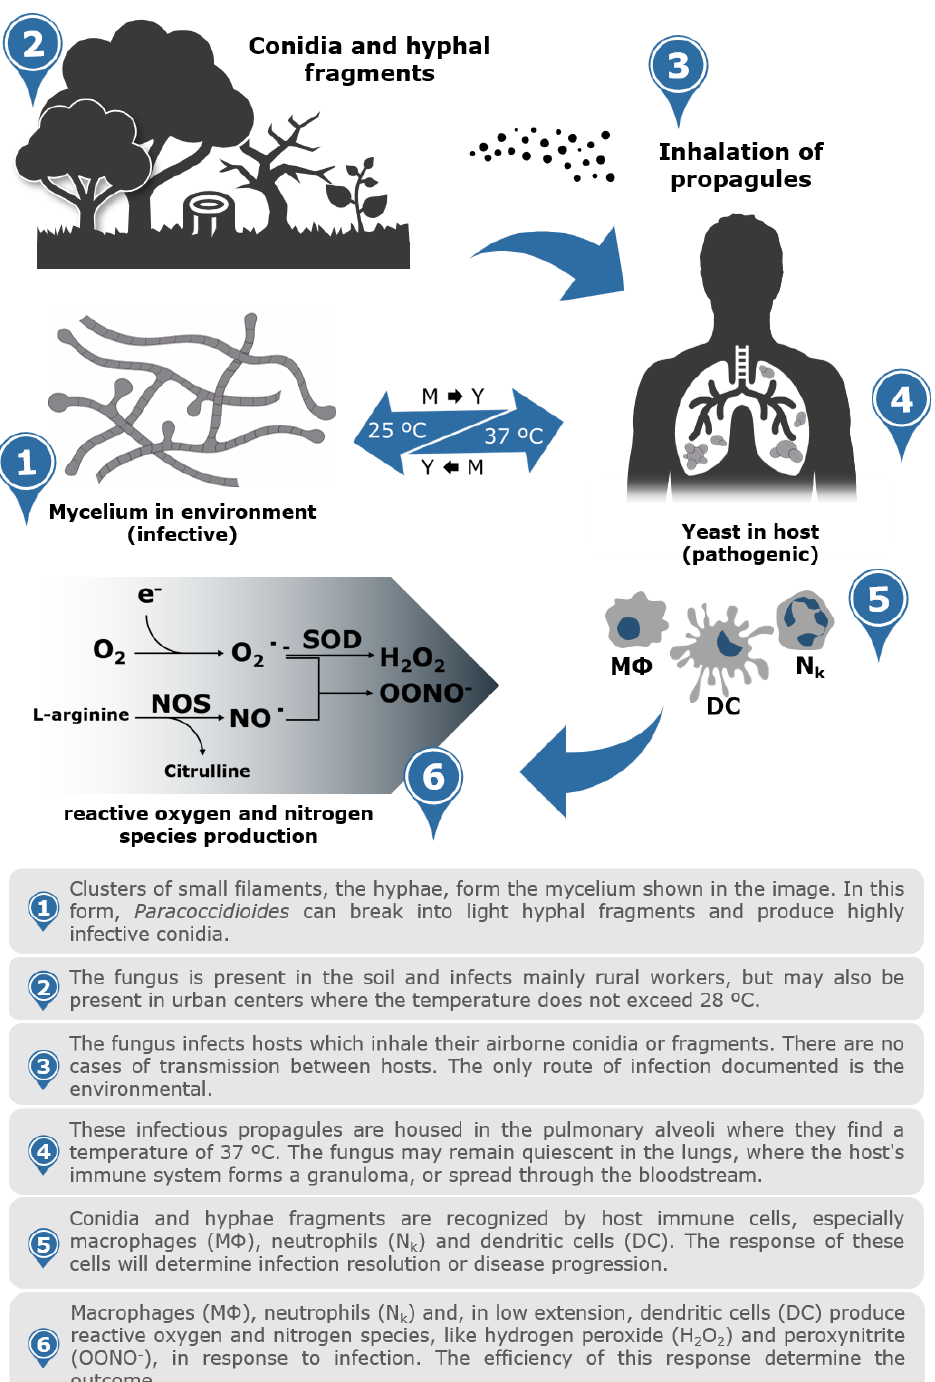
Figure 2. Infographic of Paracoccidioides species life cycle from the environment to the host. The saprophytic form of Paracoccidioides spp. are found in the soil as mycelium (25 °C). Conidia and hyphal fragments inhaled by mammalian hosts are the primary sources of infection. The propagules are inhaled and established in the lungs, which, at body temperature (37 °C), initiate the dimorphic transition to pathogenic yeast form. The immune cells present within the host, such as macrophages, neutrophils, and dendritic cells, recognize the pathogen and trigger defence mechanisms such as the production of reactive nitrogen and oxygen species (RNS/ROS).